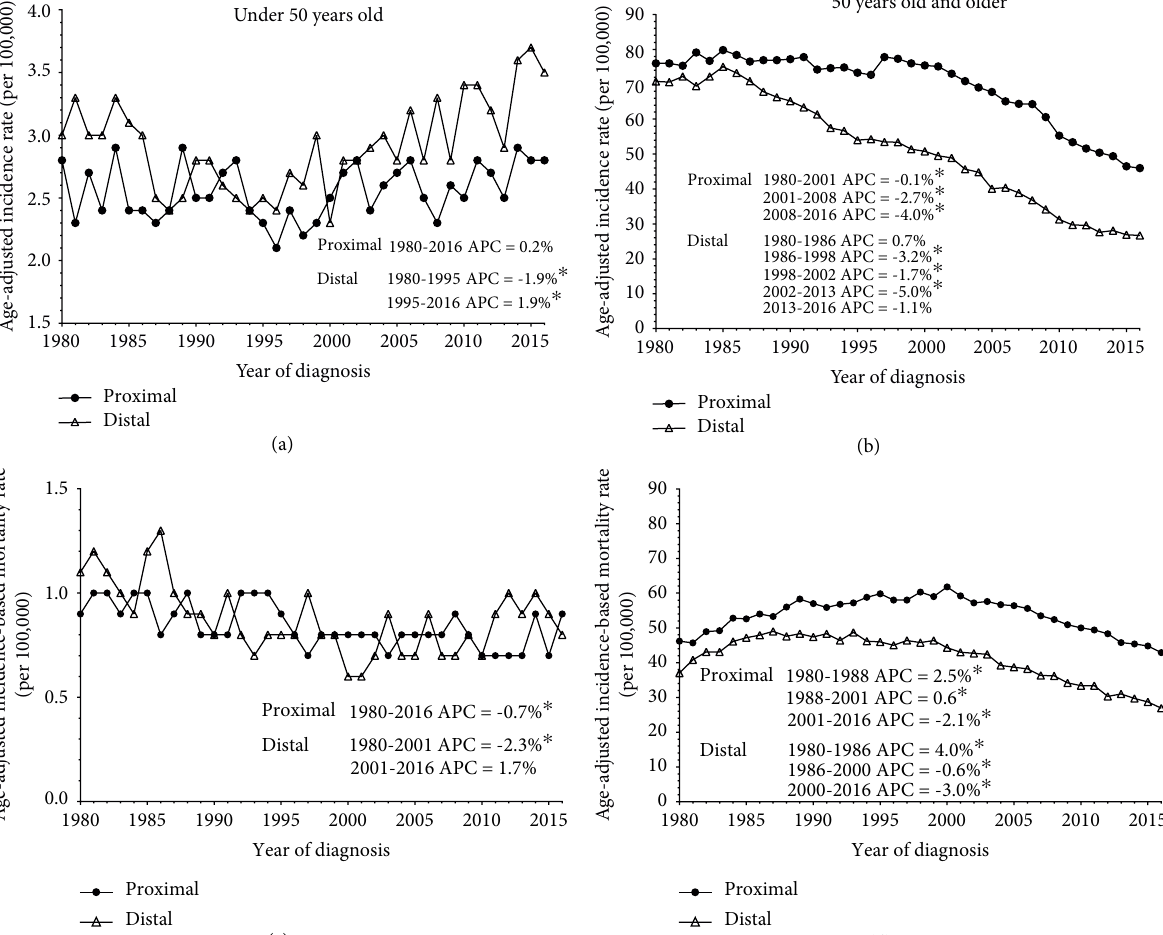
Figure 3: Trends in colon tumor subsite-specific incidence and mortality rates among individuals age 20–49 and 50 and older, 1980–2016. Age-adjusted incidence and mortality rates per 100,000 from 1980–2016 were derived from SEER9 program data and subdivided into proximal and distal colon tumor subsites using ICD-O-3 codes, to examine rates over time. Proximal and distal colon cancer incidence and IBM rates are depicted for age 20–49 (a, c) and 50 and older (b, d). Asterisks ( ∗ ) designate statistical significance calculated in the permutation model.